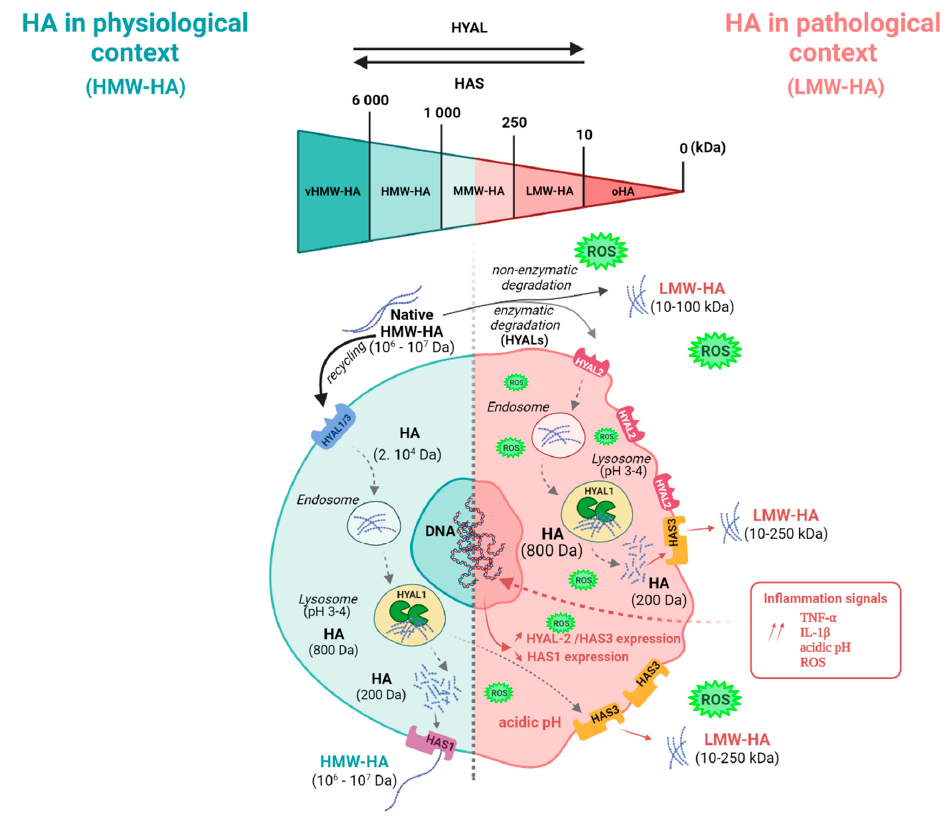
Figure 1. Catabolism and recycling of HA. In a physiological context, native HA (>1000 kDa) is mainly recycled by HYAL1 and HYAL3. Its intracellular degradation continues within lysosomal vesicles to reach a 200 Da size. HAS1 mainly performs the neo-synthesis of HMW-HA. In a patho- logical/inflammatory context, HMW-HAs are fragmented by ROS and HYAL (mainly HYAL2) to form LMW-HAs with a size between 10 and 250 kDa, then degraded into 200 Da-sized fragments in lysosomes. The neo-synthesis of LMW-HA (10–250 kDa) occurs through HAS3. Created with Bio- Render.com.